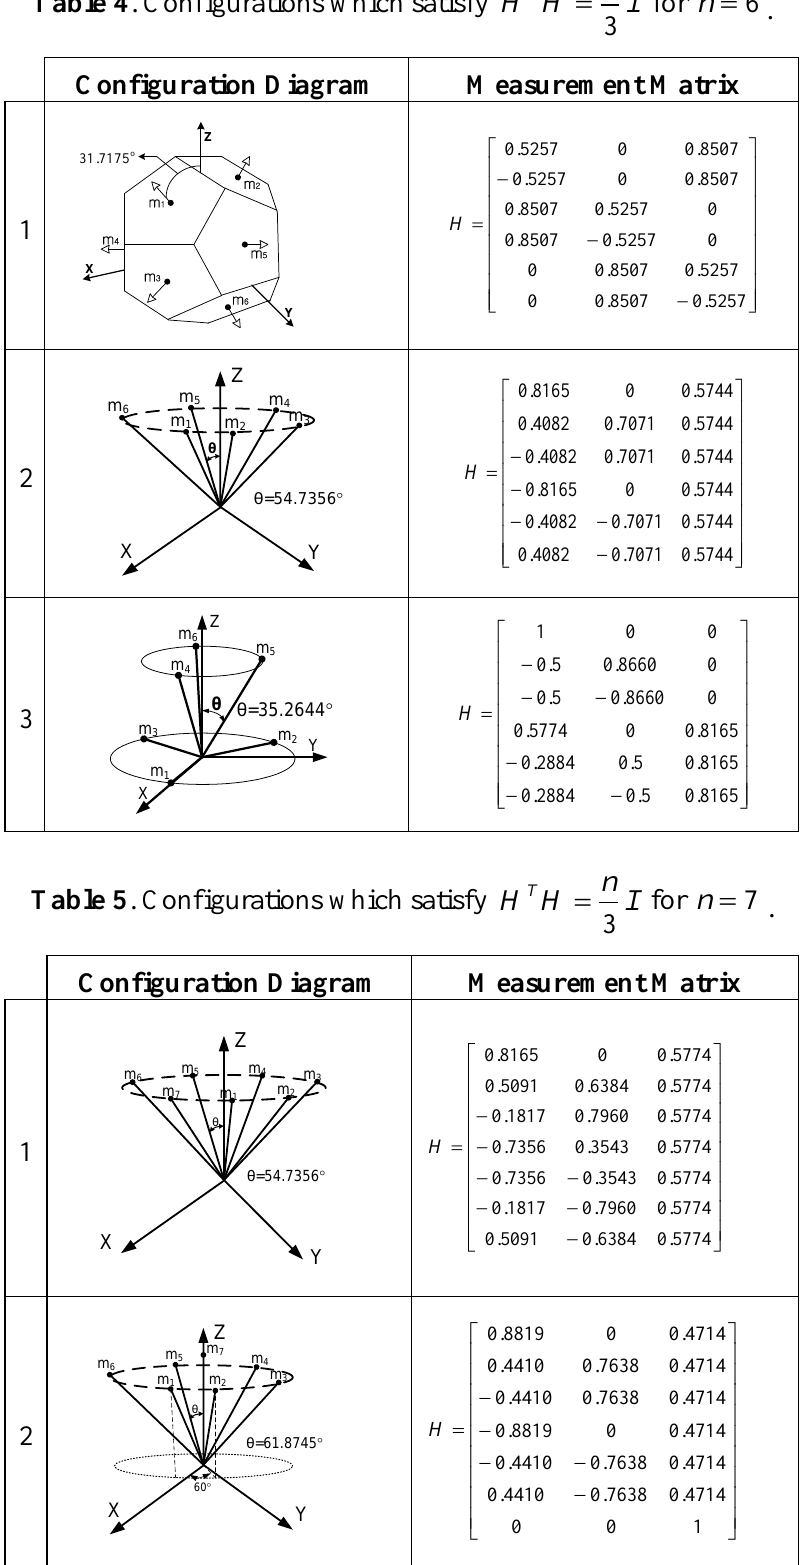
Table 4 . Configurations which satisfy